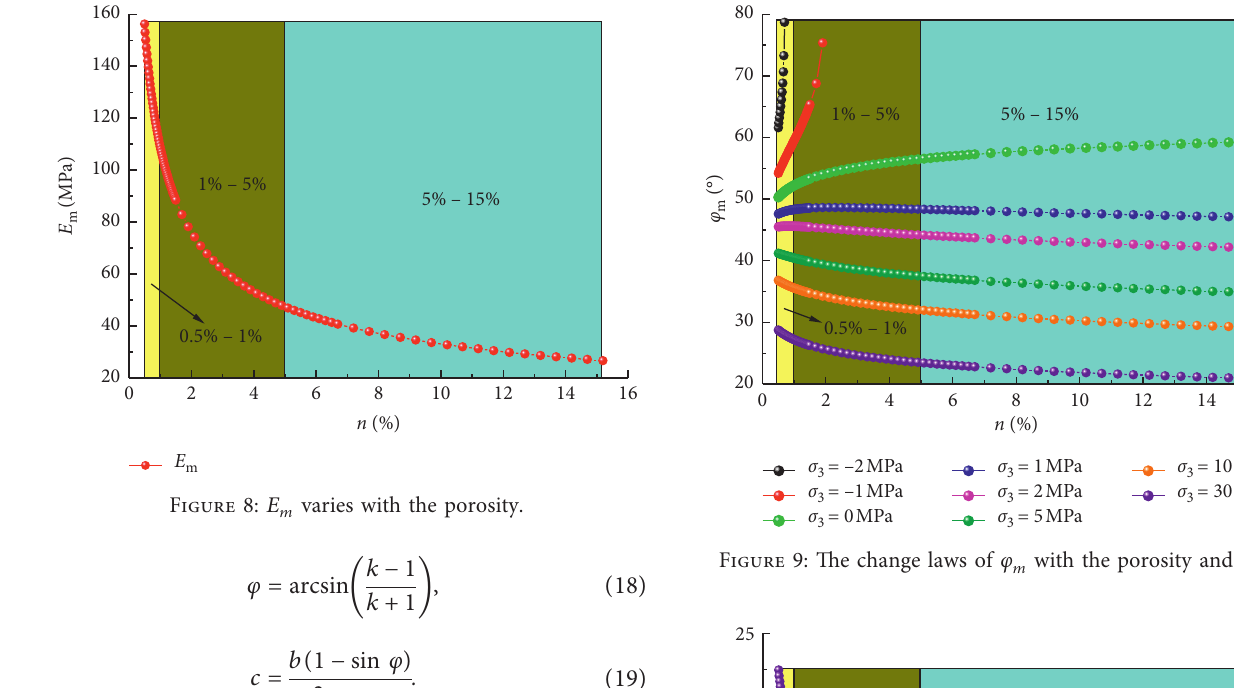
m with the porosity and σ 3.